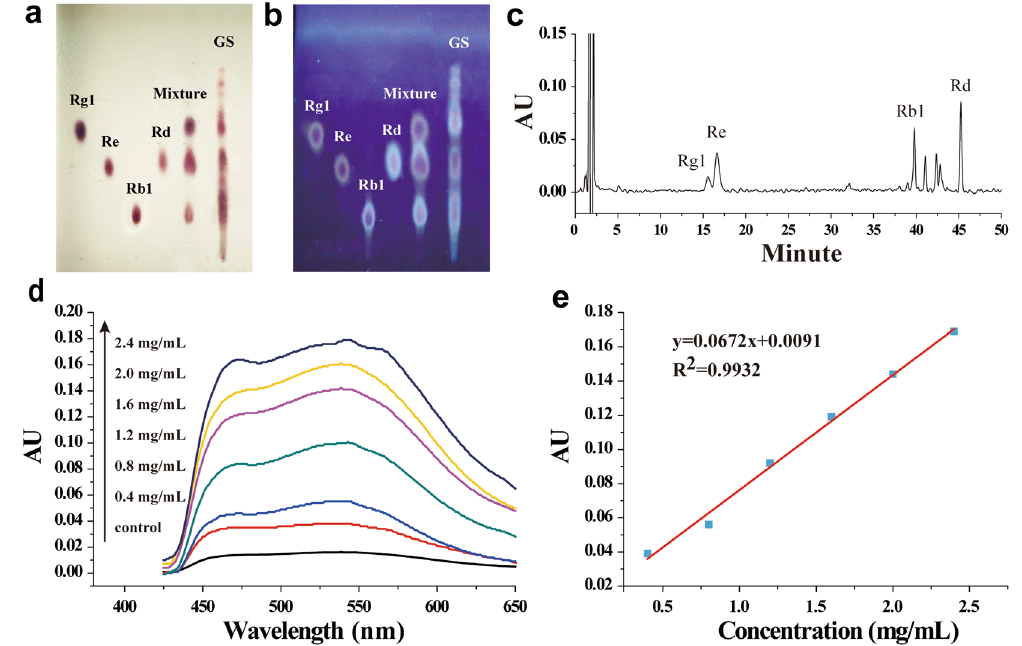
Figure 1. Quality control analysis of the most-consumed ginsenoside powder. ( a , b ) The quality control solutions of purified ginsenosides (GS), and standardized ginsenoside component Rg1, Re, Rb1, and Rd were pipetted on to SiO 2 -coated thin layer chromatography plates, respectively, and developed with the mobile phase followed by chromogenic stain (10% H 2 SO 4 ), and sunlight ( a ) and UV exposures ( b ). The results demonstrated that the test GS contained Rg1, Re, Rb1, and Rd. ( c ) HPLC chromatograms showed the peaks and retention times of each active component from the purified GS. ( d ) Scanning of ultraviolet spectra of